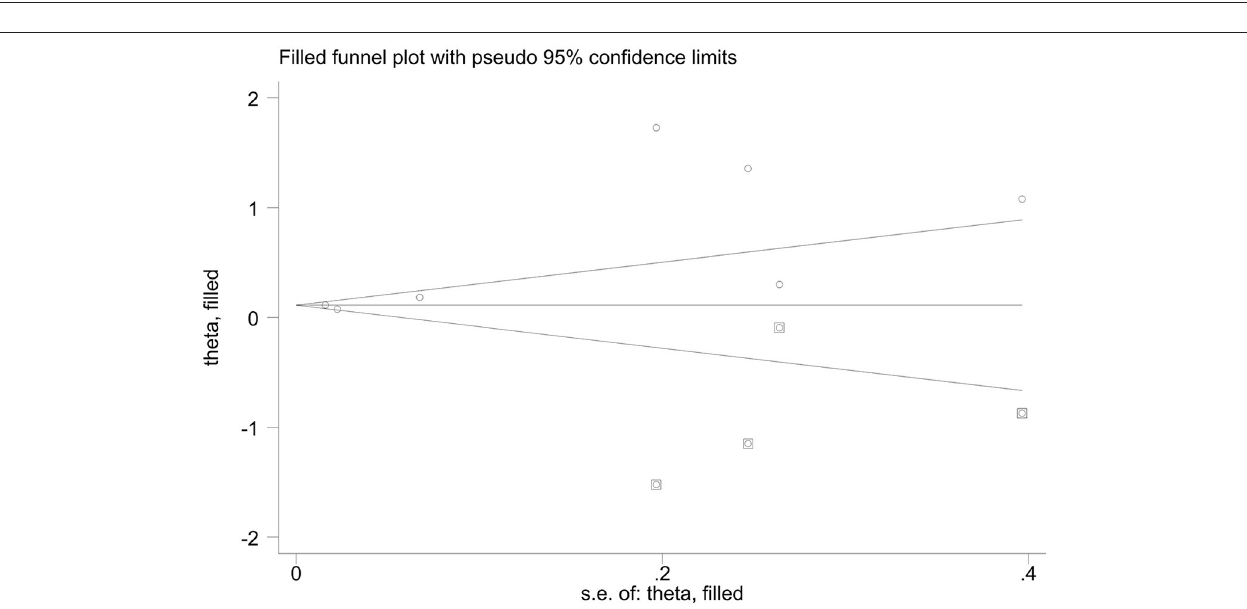
FIGURE 5 | The forest plot illustrated the OR for various depression assessment scales estimating risk factor of CF.